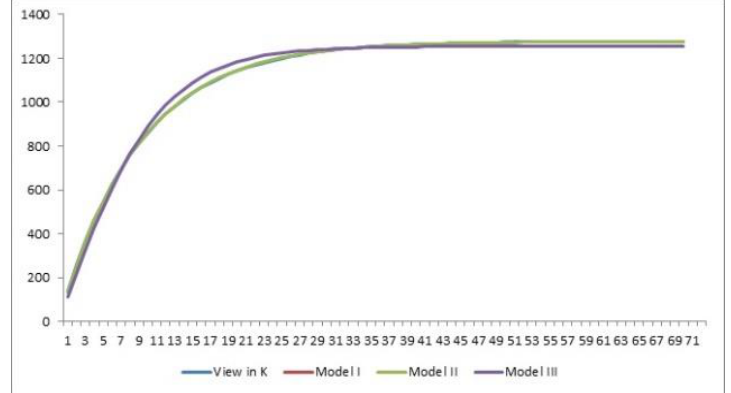
Figure 1. Goodness of fit curve of Dataset 1